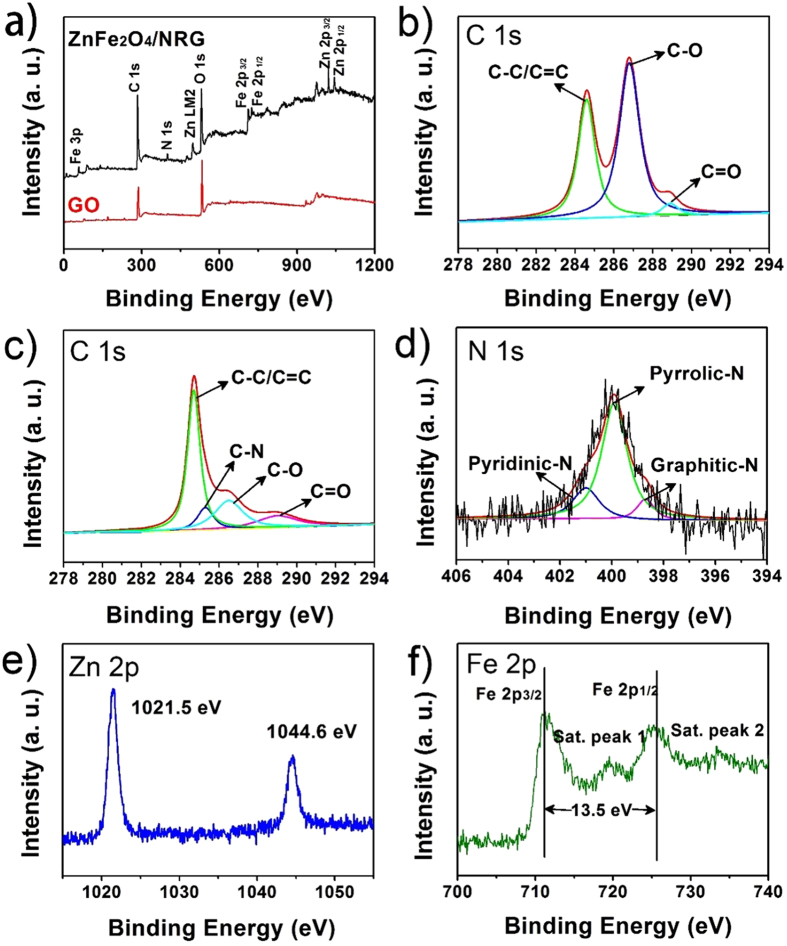
XPS survey spectra of GO and ZnFe2O4/NRG composite (a); C 1 s of GO (b) and ZnFe2O4/NRG (c), N 1 s (d), Zn 2p (e) and Fe 2p (f) of ZnFe2O4/NRG composite.